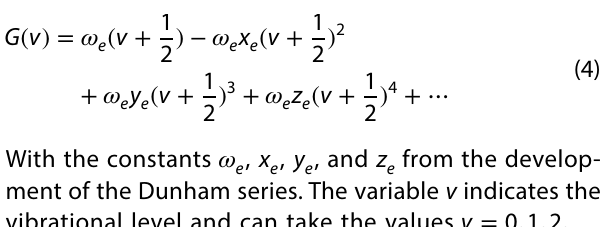
Fig. 3 a Schematic illustration of the electronic (black), vibra- tional (blue) and rotational (red) energy levels of the SPS of N . b Shows a spec- 2 trum resulting from different transitions in the SPS from ( a ). The 𝛥 v shows the difference from the vibrational level of the higher electronic level to the vibrational state v ′ to vibrational level of the lower electronic